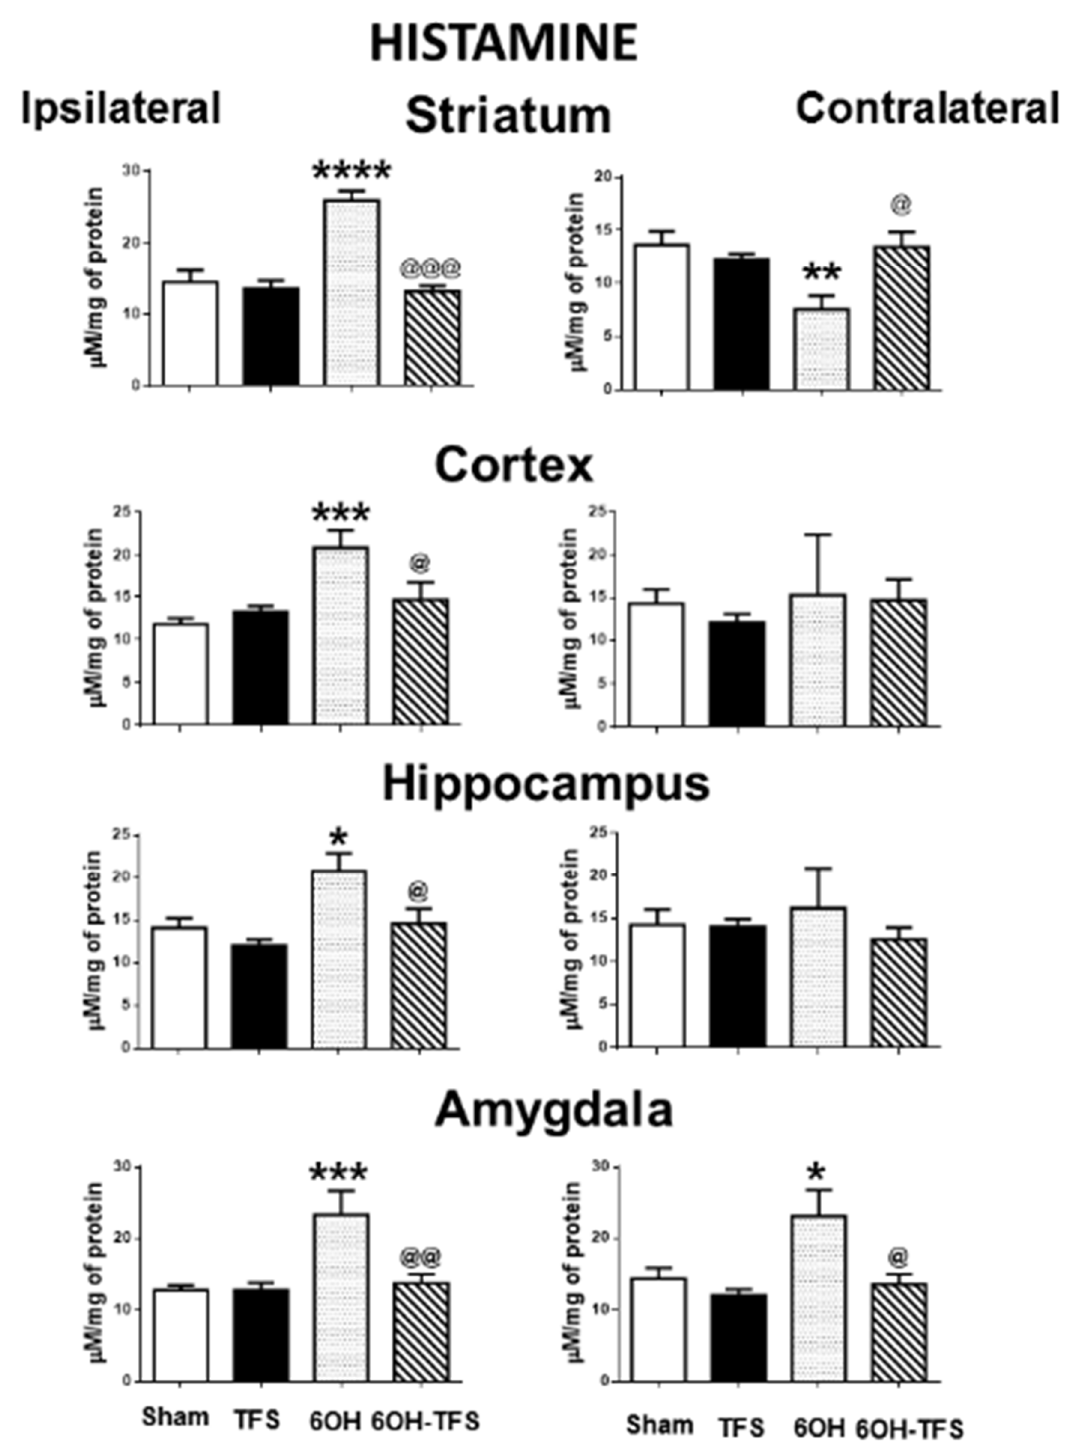
Figure 3. Effects of TFS on the changes of histamine tissue content induced by 6-OHDA in different brain areas. Notations as in Figure 1. * p < 0.05 vs Sham group; ** p < 0.01 vs Sham group; *** p < 0.001 vs Sham group; **** p < 0.0001 vs Sham group; @ p < 0.05 vs 6-OHDA group; @@ p < 0.01 vs 6-OHDA group; @@@ p < 0.001 vs 6-OHDA group. The results obtained were analyzed with ANOVA followed by the post hoc Tukey test.